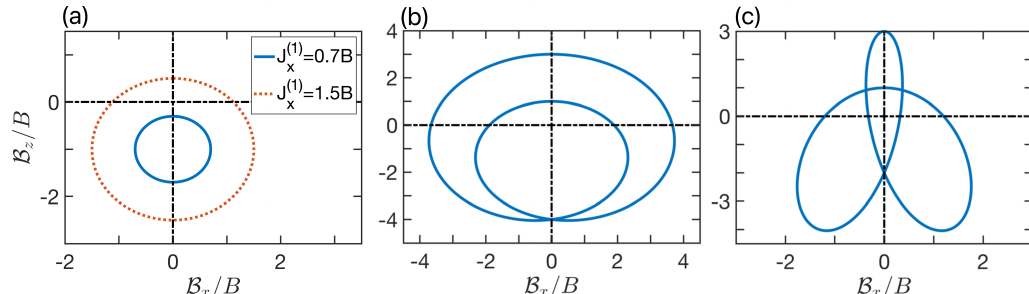
Figure 3: Example of the topological winding number in the extended Ising model with closed boundary